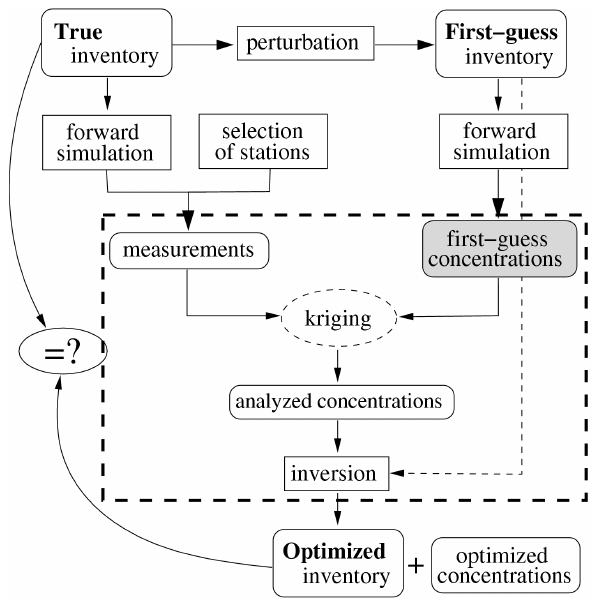
Fig. 1. Principle of the evaluation of the inverse modeling method- ology with synthetic cases. The bold-dashed area contains the steps of the inverse modeling methodology itself, which would be per- formed in a real-case study.